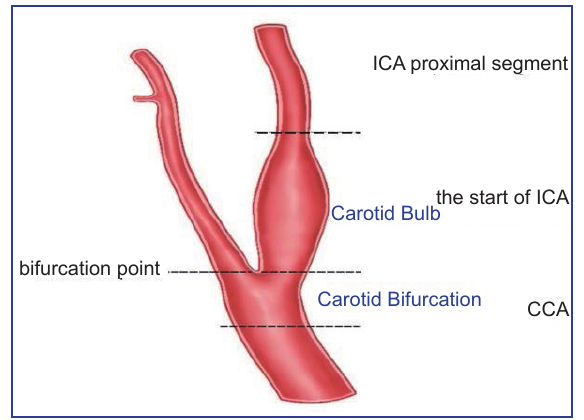
Figure 3 Diagram of common carotid artery bifurcation, carotid bulb, and proximal segment of the internal carotid artery.